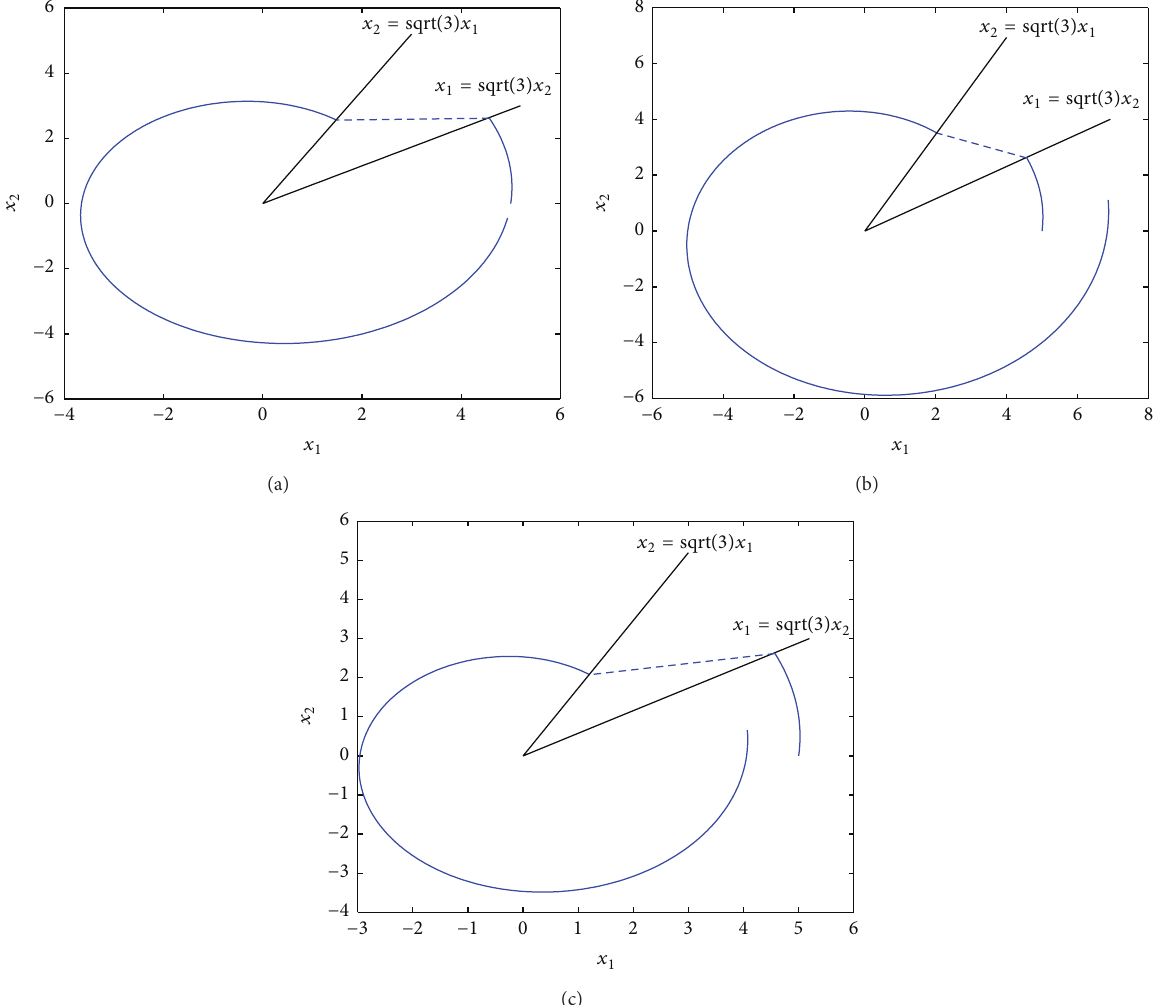
Figure 1: The center and focus of system (48a) and (48b). (a) The center, where 𝑏 0 = 0.5622 . (b) An unstable focus, where 𝑏 0 = 0.7697 . (c) A stable focus, where 𝑏 0 = 0.4559